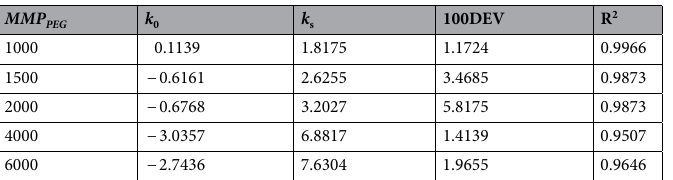
Experimental Calculated